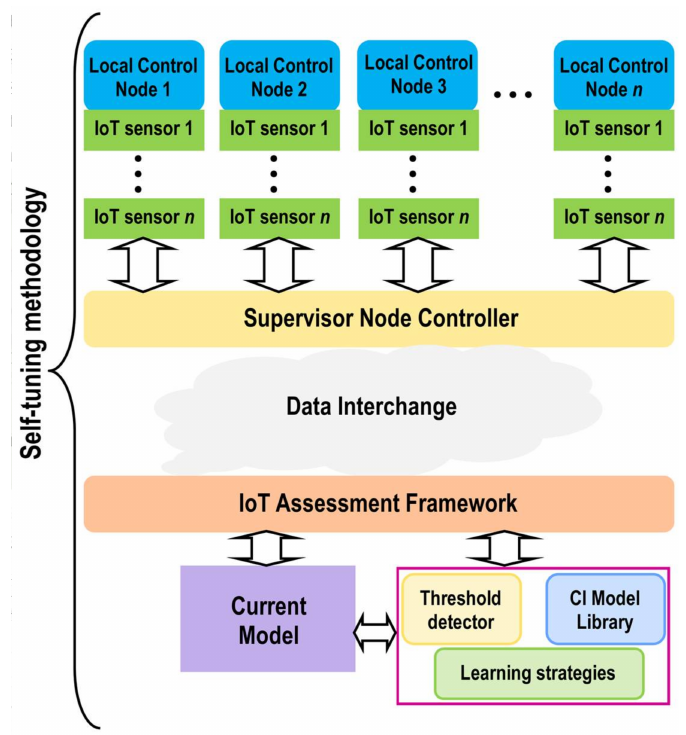
Figure 1. Conceptual design of self-tuning method. Iteration between IoT assessment framework and supervisor node